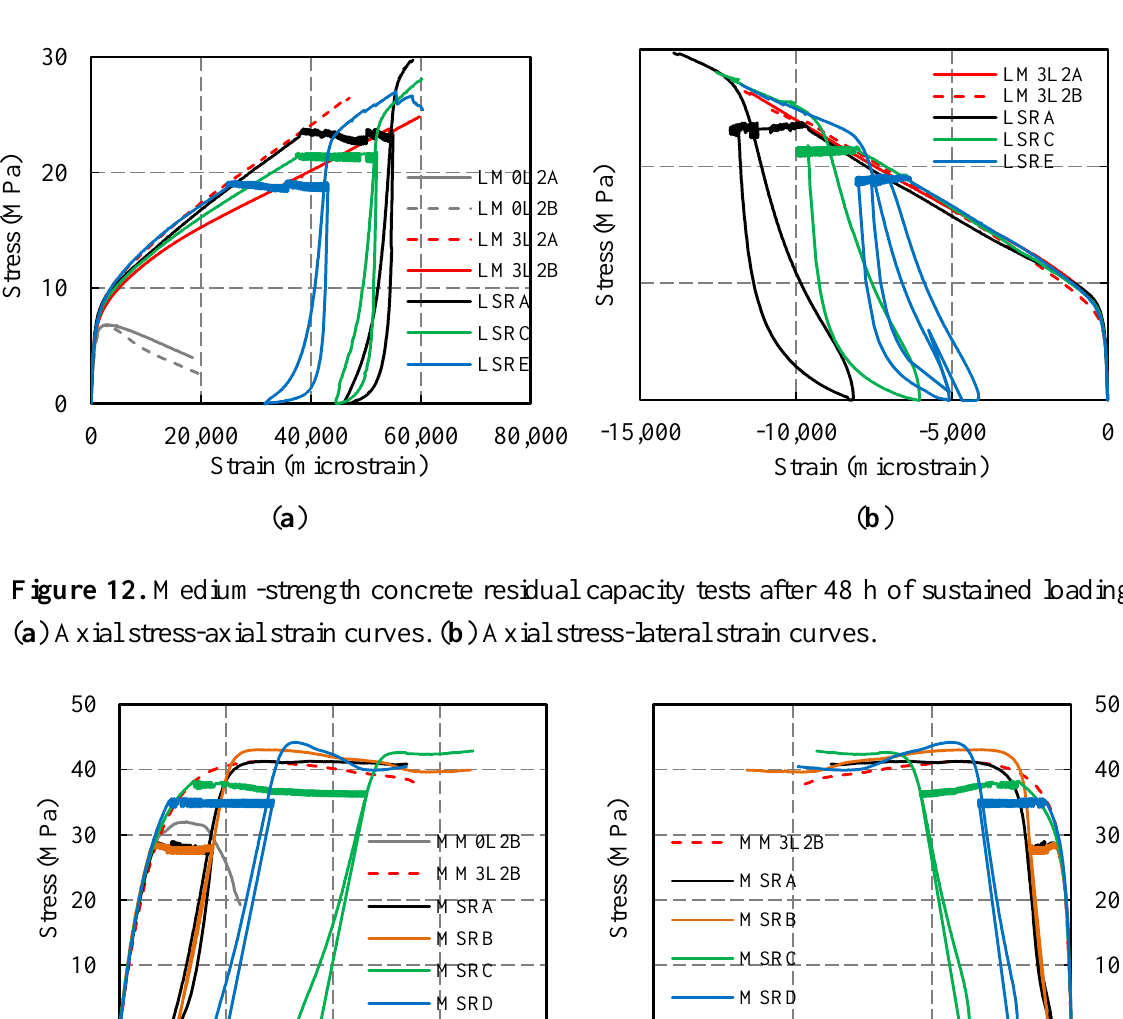
Figure 11. Low-strength concrete residual capacity tests. ( a ) Axial stress-axial strain curves. ( b ) Axial stress-lateral strain curves.